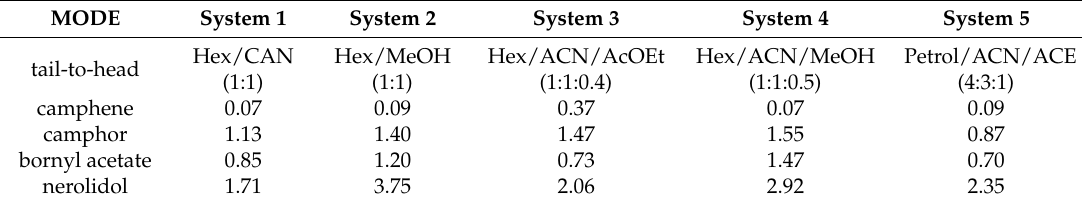
Table 2. Distribution coefficient ( KD ) values in different solvent systems tested for the preparative isolation of terpenes from P. mollicomum leaf essential